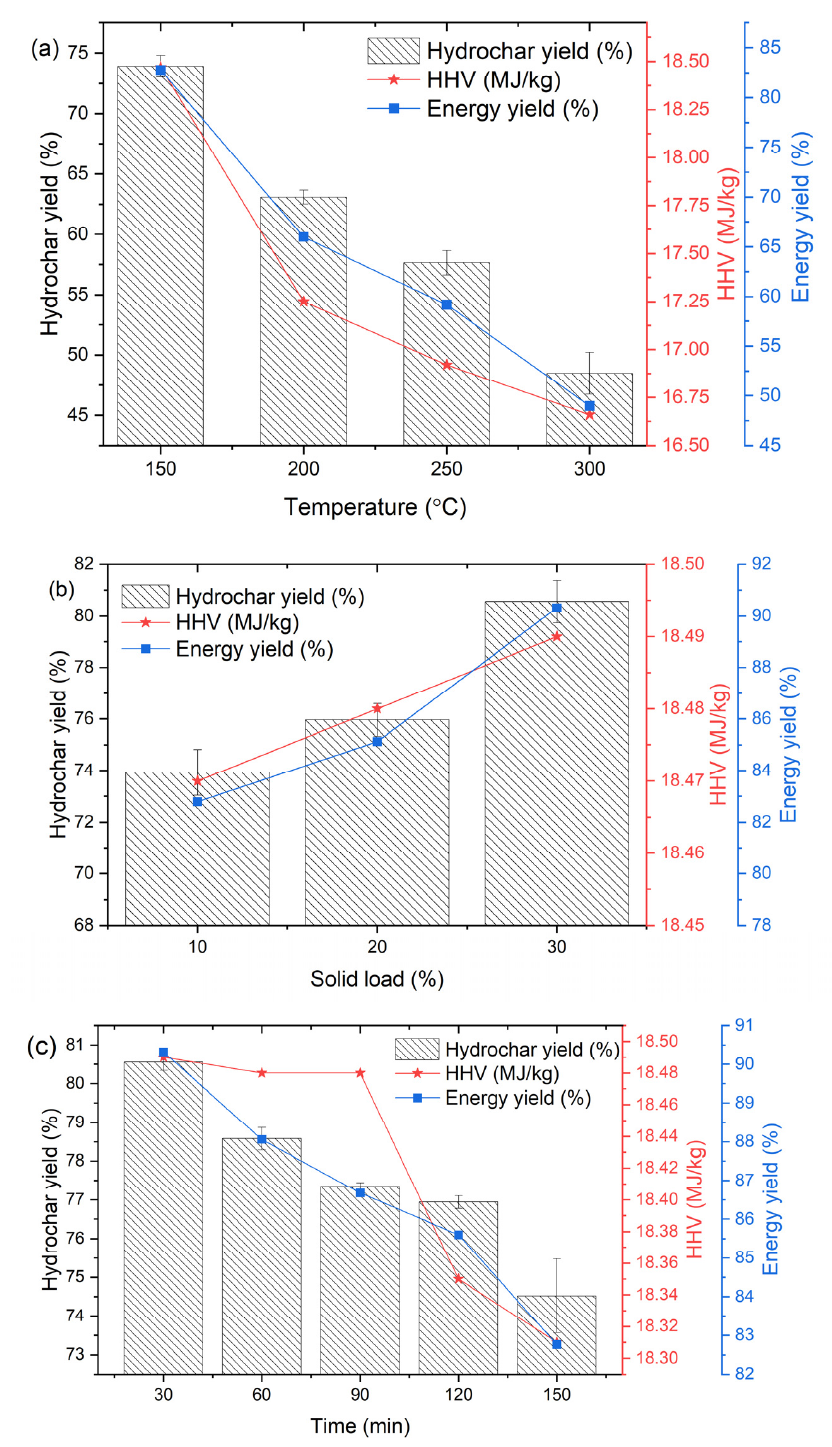
Figure 3. Effects of HTC conditions on solid yield, HHV and energy yield; ( a ) temperature at fixed 10% solid loading and 30 min; ( b ) solid loading at fixed temperature 150 °C and 30 min; and ( c ) reaction time at fixed temperature 150 °C and 30% solid loading.